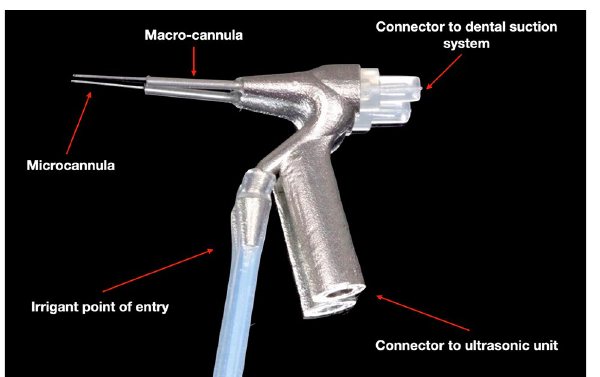
Figure 2. Prototype of